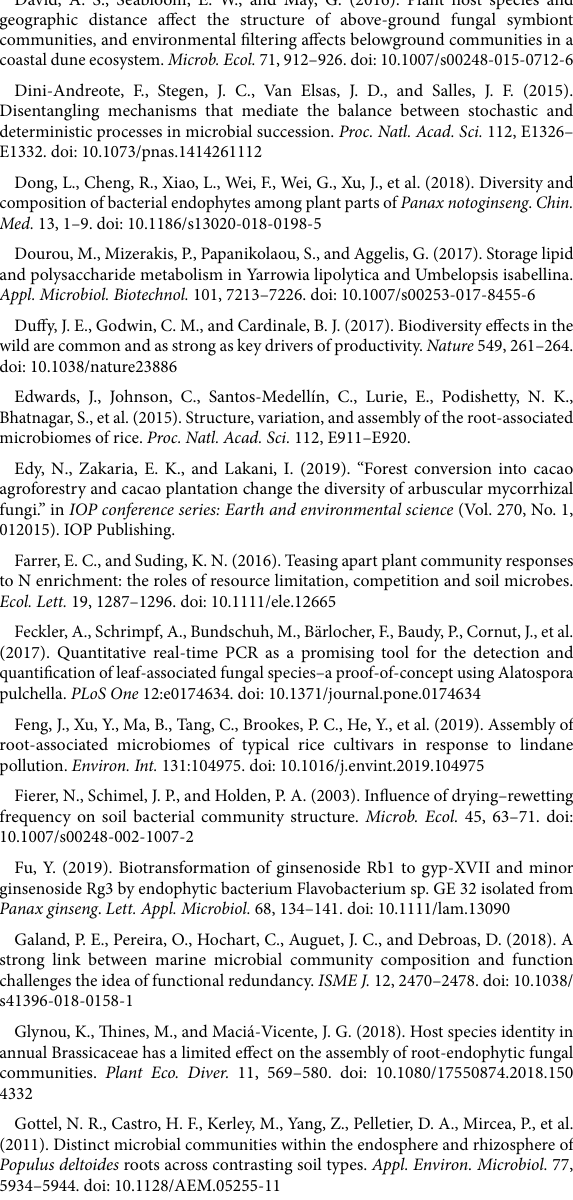
SUPPLEMENTARY FIGURE S9 Student t -test bar plots for different compartments of fungal